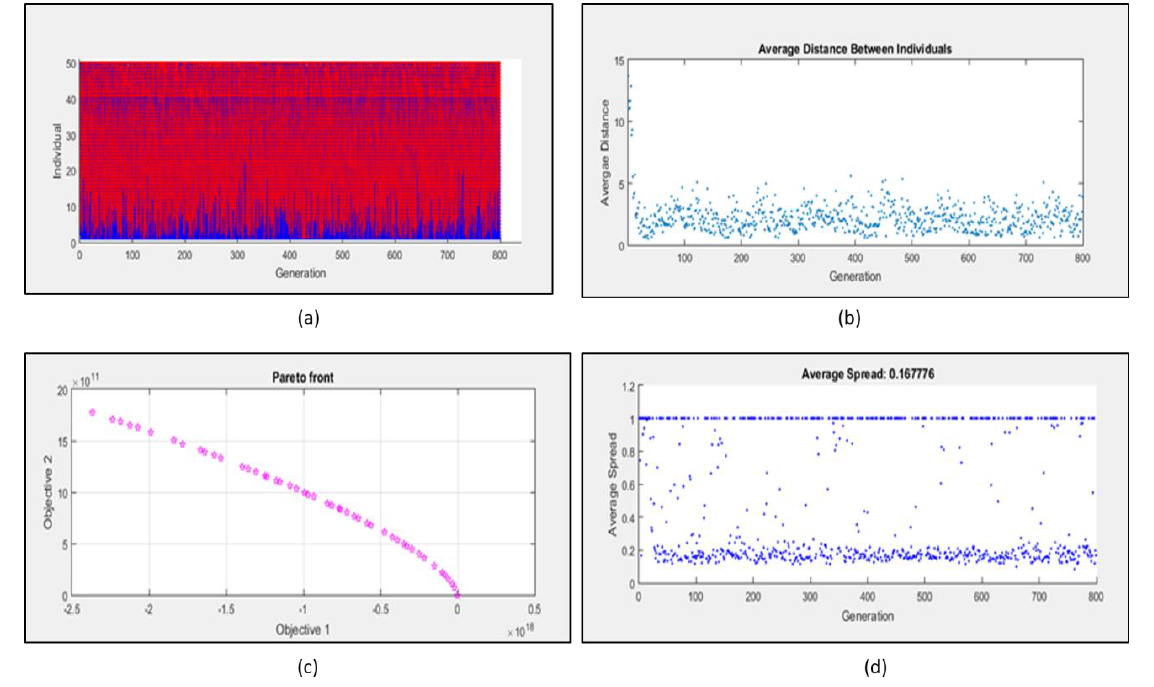
Figure 5. Multi objective genetic algorithm for optimization of SOCS1/SOCS3 ratio ( a ) Graph of elite population ( b ) Graph showing average distance between individuals indicating the decreased mutation rate ( c ) Pareto front between two objective function representing non-dominated solution ( d ) Graph depicting the average spread measure of the solution.